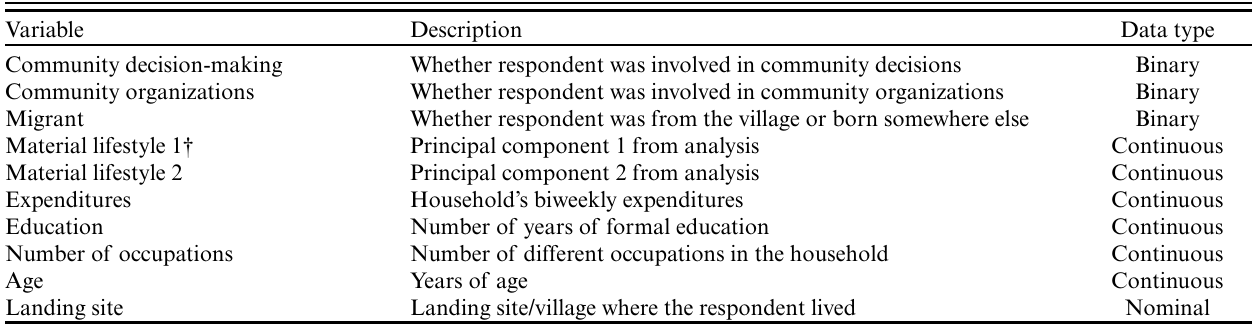
Table 1. Description of independent variables used in the